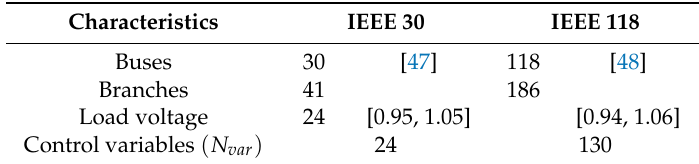
Table 1. Power system’s parameters.